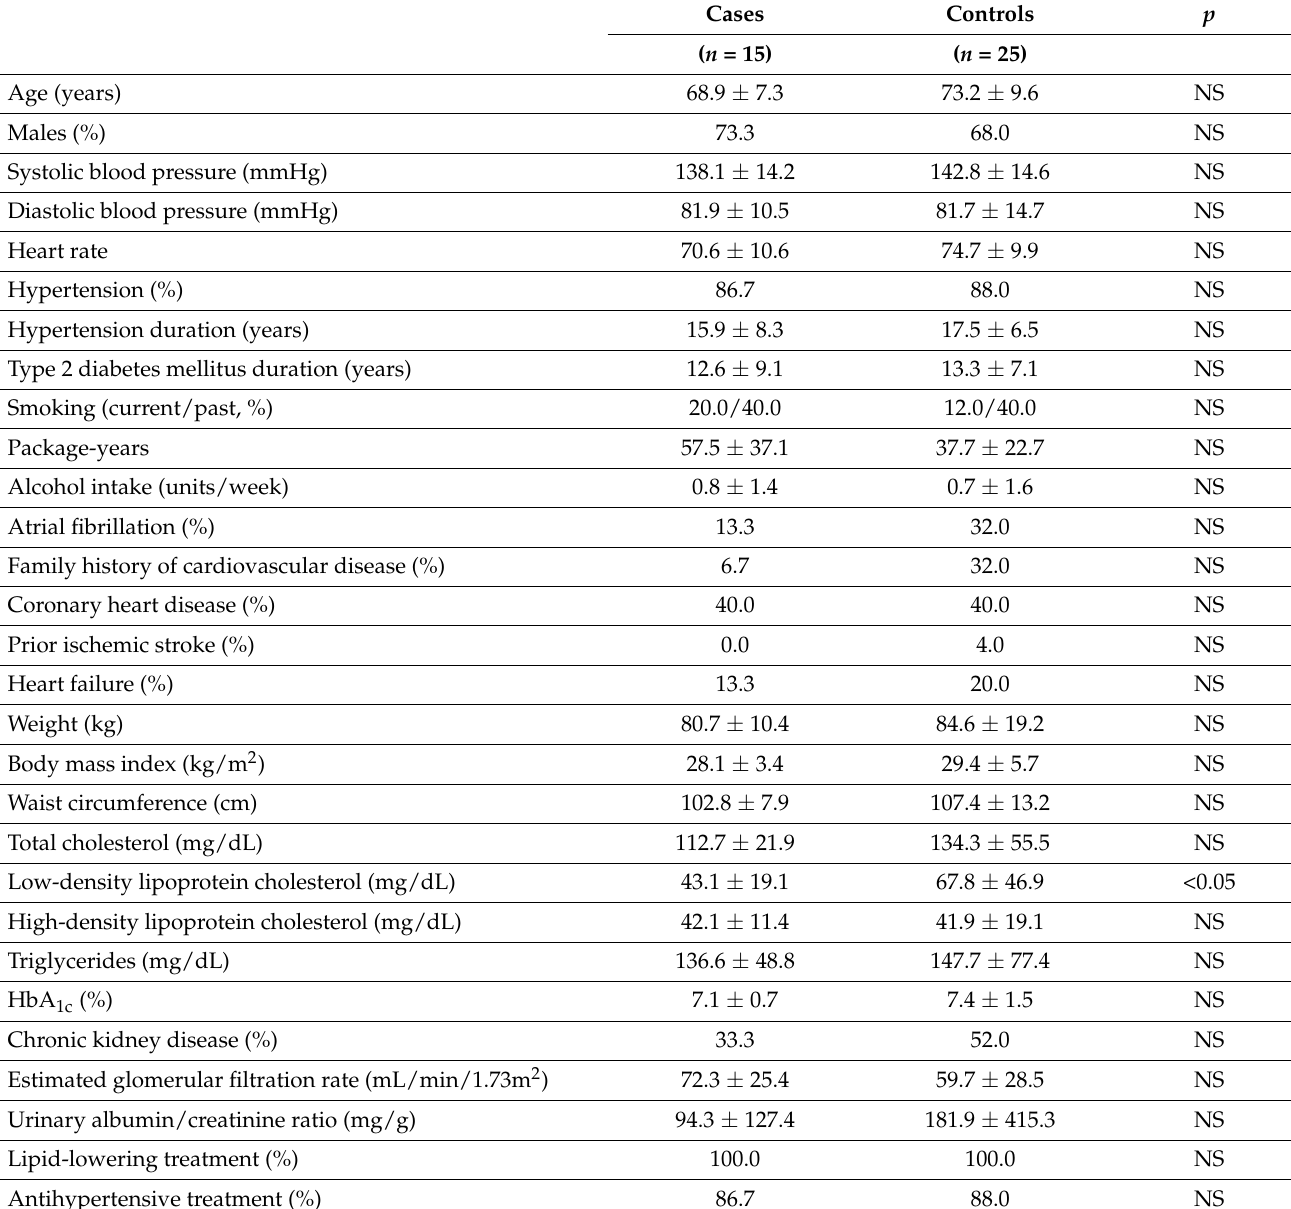
Table 1. Characteristics of patients treated and not treated with sodium-glucose co-transporter 2 (SGLT2) inhibitors (cases and controls,